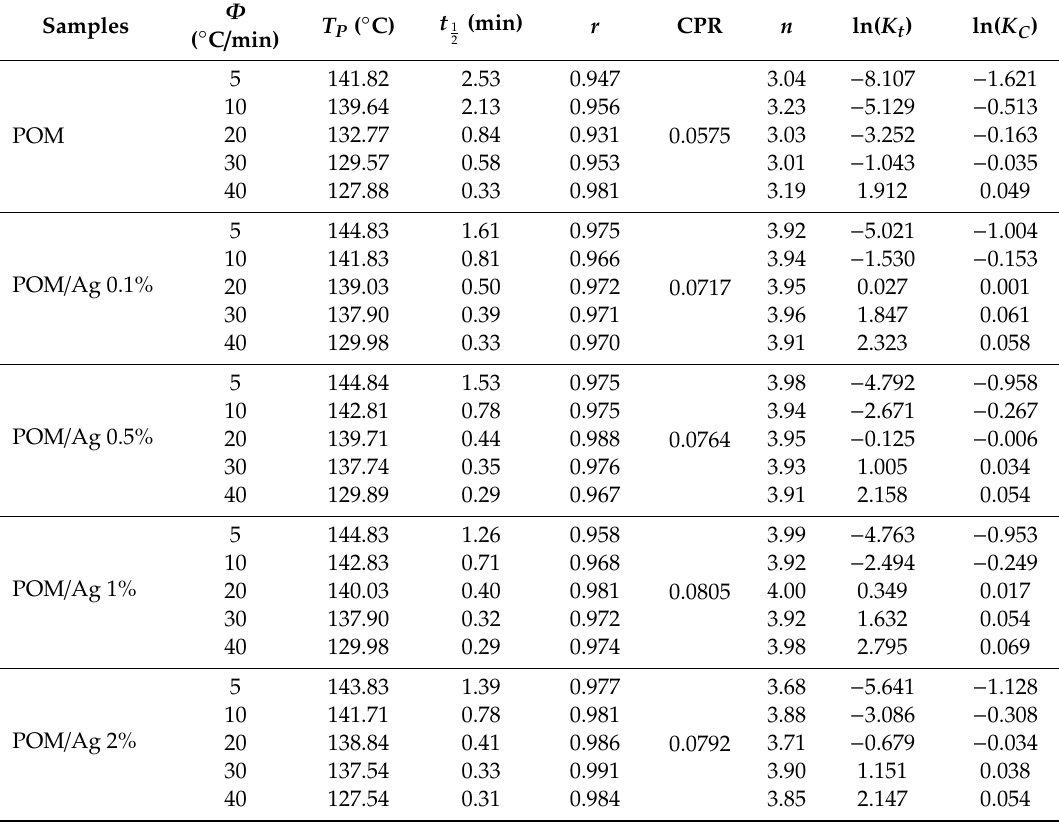
Table 2. Parameters of Jeziorny and Jeziorny-modified Avrami analysis for the POM / Ag